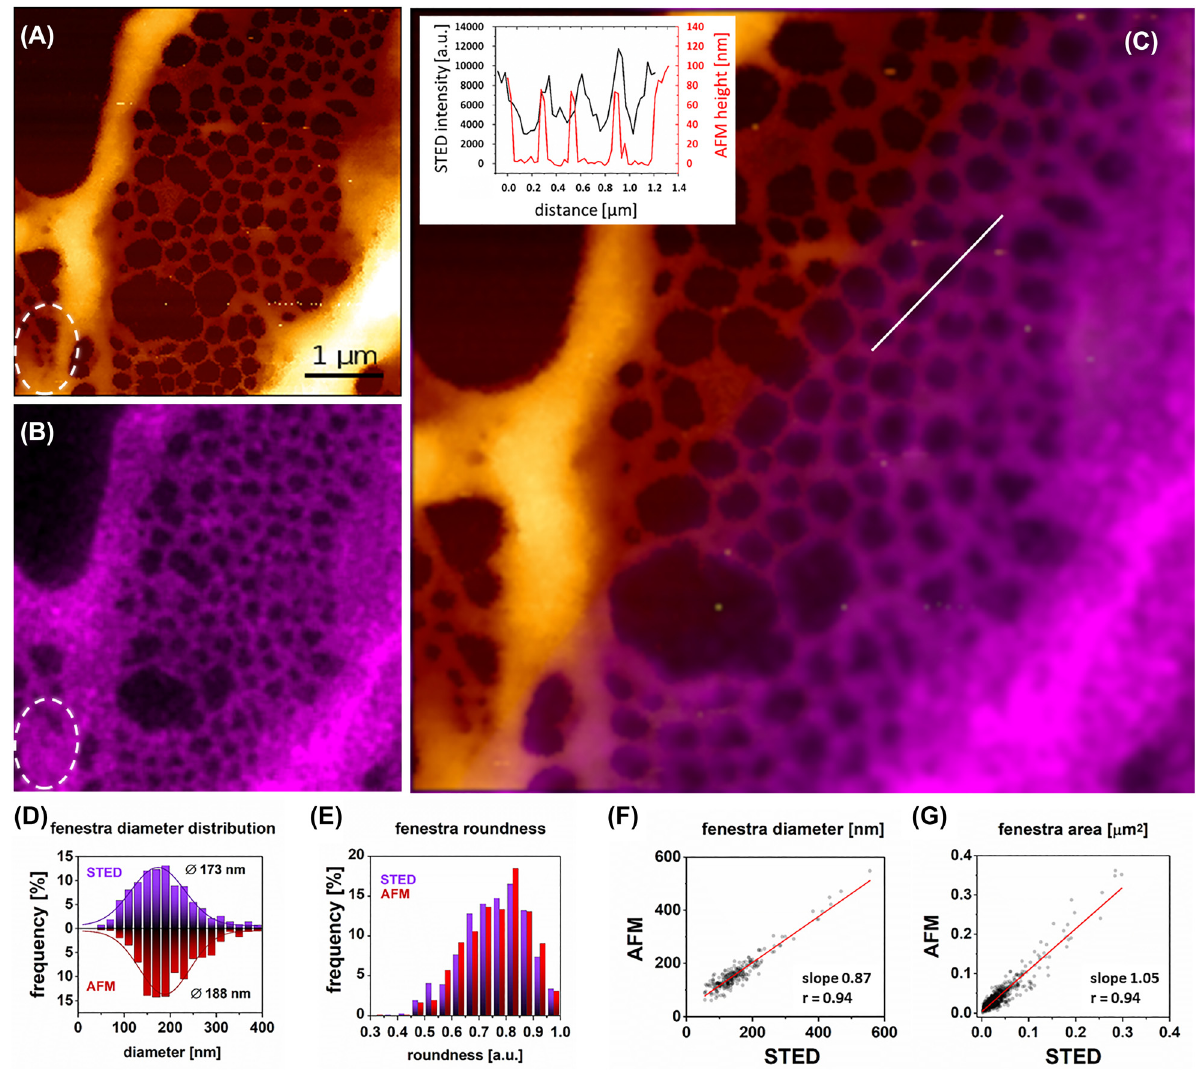
Figure 5: Correlative AFM and STED